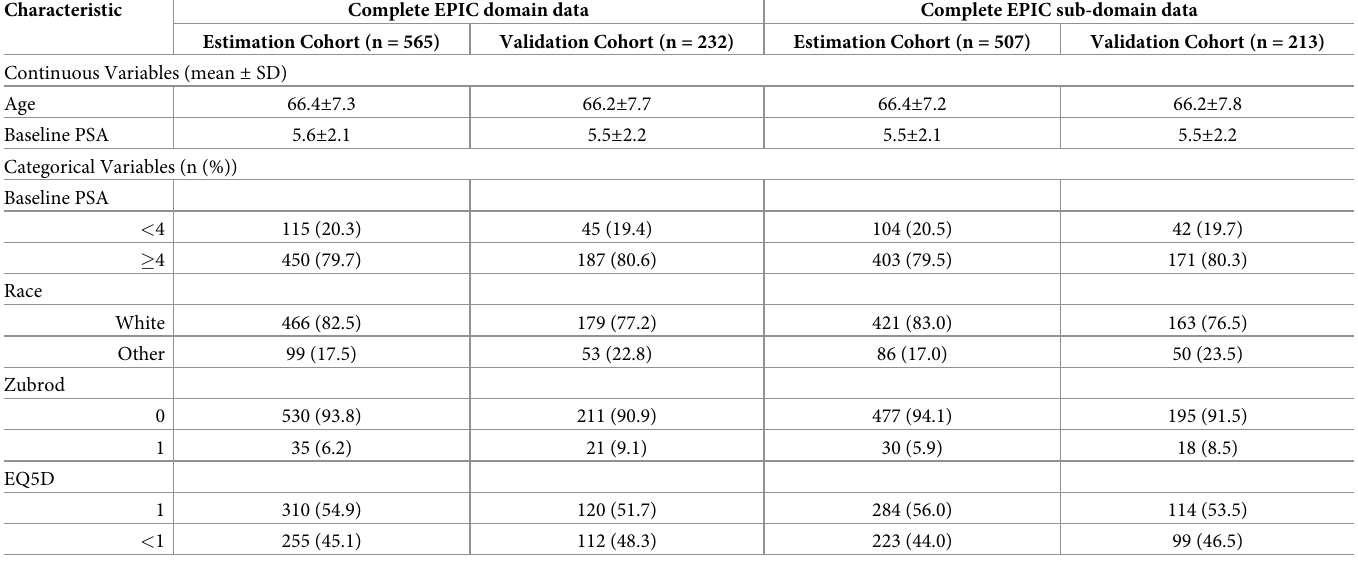
Table 1. Baseline characteristics of patients with complete EPIC domain and subdomain